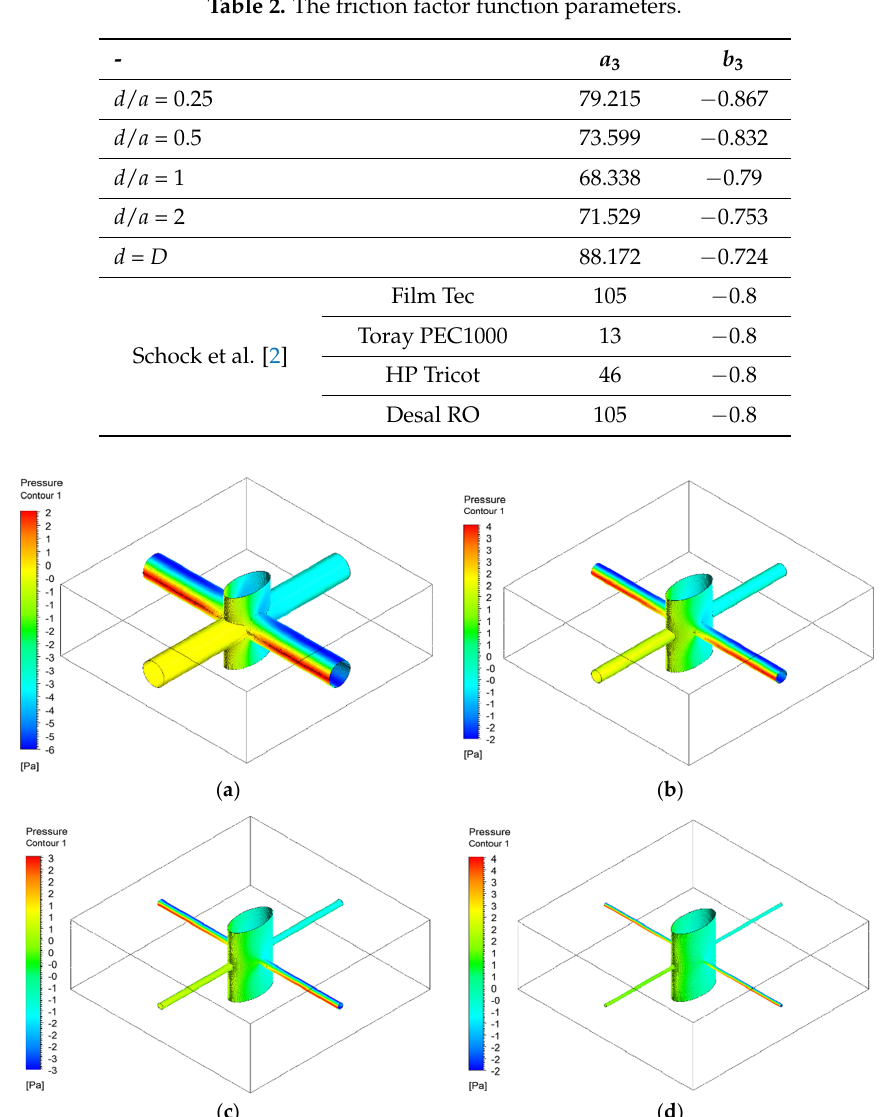
Figure 10. The contours of total pressure in the main flow direction for the super velocity of 0.04 m/s (red: high, blue: low). ( a ) d/a = 2; ( b ) d/a = 1; ( c ) d/a = 0.5; ( d ) d/a = 0.25.